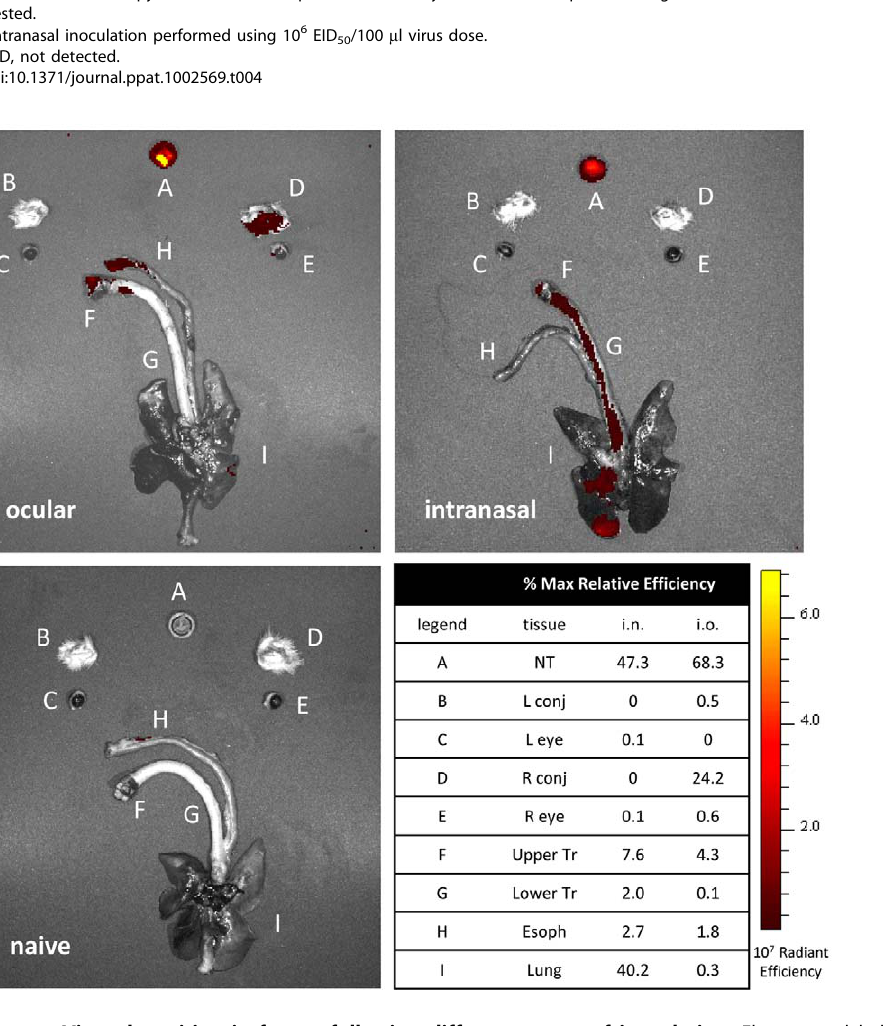
Figure 4. Virus deposition in ferrets following different routes of inoculation. Fluorescent-labeled A/NL/219/03 virus (NL219-FL) was administered to ferrets by the intranasal or ocular route. Each ferret was euthanized 15 min following virus administration and organs were collected for ex vivo imaging. Nasal turbinates are contained within the cap; left and right conjunctiva and eyes are below, respectively. An increasing fluorescence signal is indicated by brightness from red to yellow. Images are representative of triplicate independent inoculations for each route. Percentages represent the mean maximum relative efficiency for each tissue (n=3) above levels in corresponding naı¨ve tissue for each route of inoculation. doi:10.1371/journal.ppat.1002569.g004 PLoS Pathogens |